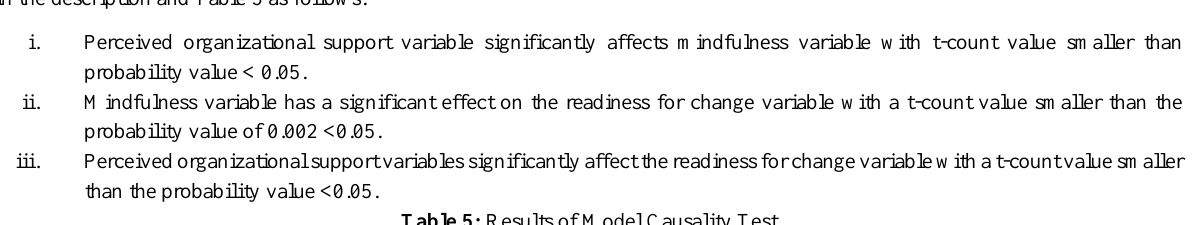
Table 5: Results of Model Causality